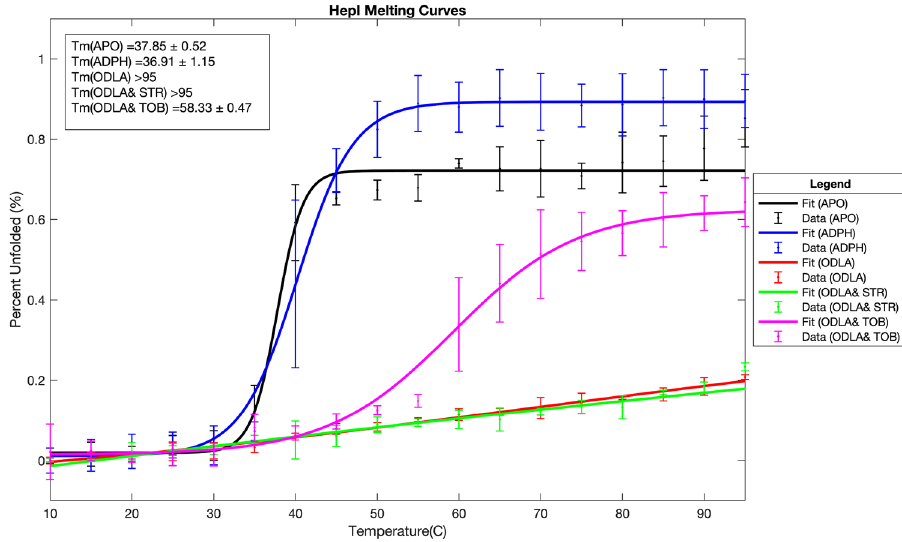
Figure 4. HepI melt curves in the presence of substrates and aminoglycoside inhibitors.